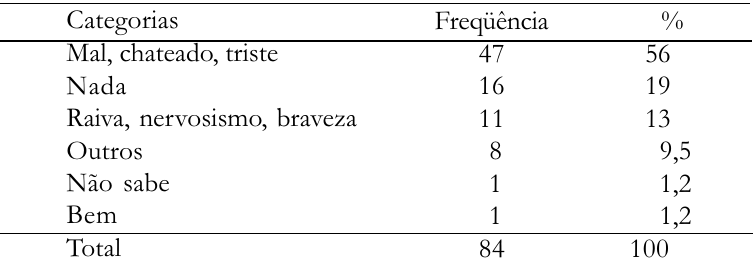
A Tabela 3 mostra que a estratØgia de coping que as crian(cid:231)as relataram utilizar com maior freq(cid:252)Œncia para lidar com